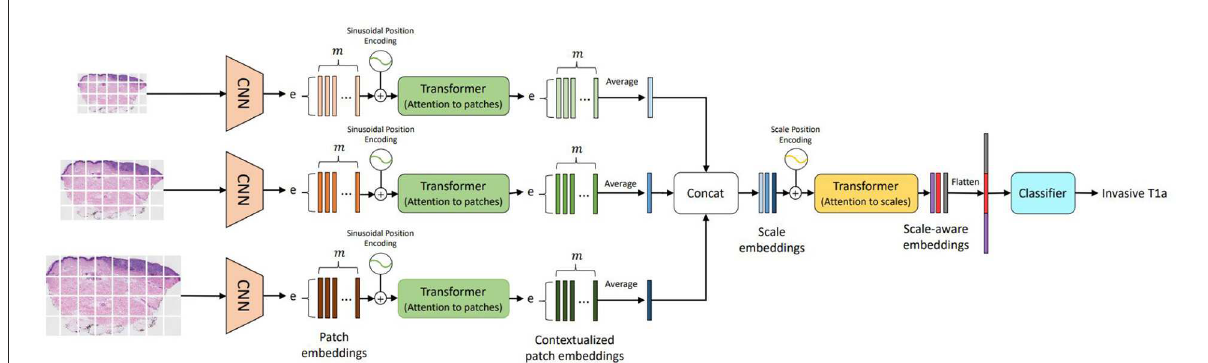
FIGURE6 Overview of ScAtNet for classifying skin biopsy images (Wu et al., 2021). To learn representations from these large WSIs at multiple input scales in an end-to-end fashion, ScAtNet factorizes the classification pipeline into three steps. The first step involves learning local patch-wise embeddings using an off-the-shelf CNN for each input scale independently. In the second step, ScAtNet learns inter-patch representations using transformers and produces contextualized patch embeddings for each input scale. In the last step, ScAtNet learns inter-scale representations from concatenated multi-scale contextualized patch embeddings using another transformer network and produces scale-aware embeddings, which are then classified linearly into diagnostic categories (This figure was published in Wu, W., Mehta, S., Nofallah, S., Knezevich, S., May, C. J., Chang, O. H., Elmore, J. G., Shapiro, L. G. (2021), “Scale-aware transformers for diagnosing melanocytic lesions,” IEEE Access 9, 163526–163541, under a Creative Commons License.).